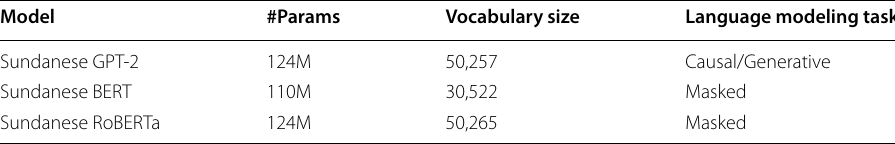
Table 1 Architecture configurations of proposed Sundanese models